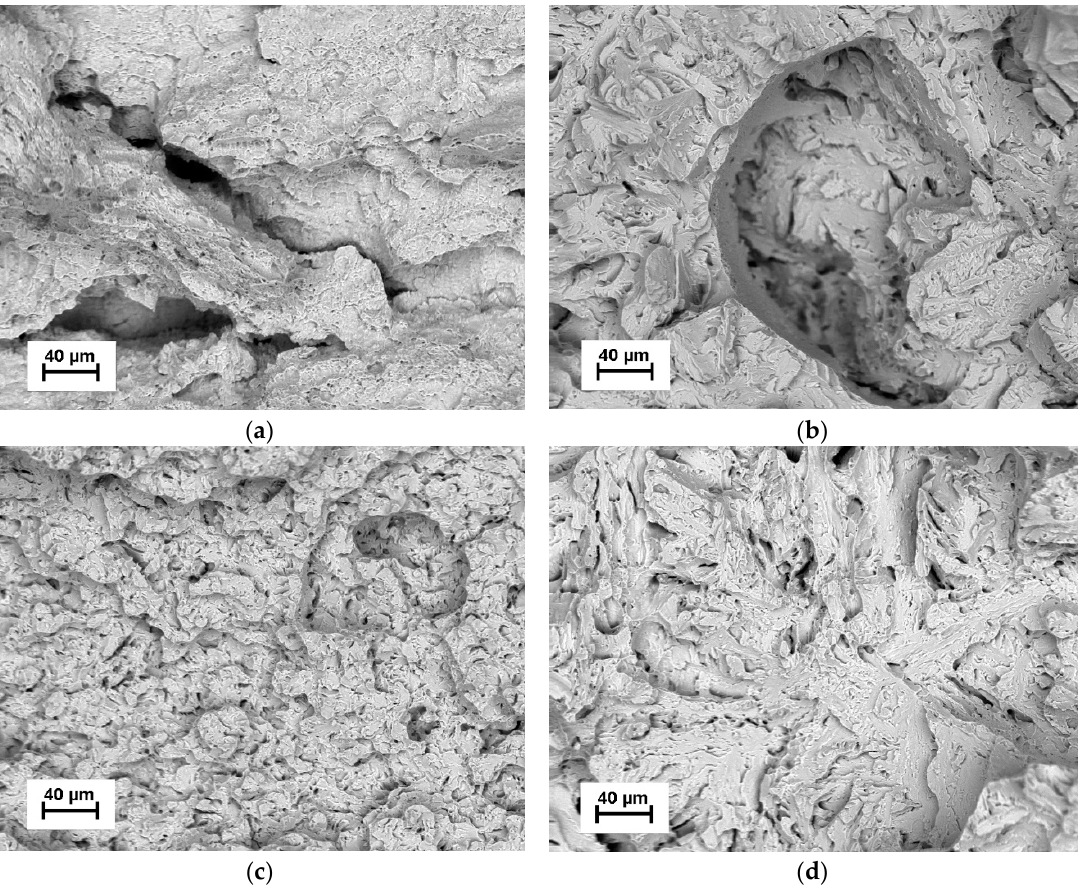
Figure 11. Fracture surface of the impact test specimens: ( a) base material; ( b ) CGHAZ at t 8/5 = 15 s; ( c ) ICHAZ at t 8/5 = 15 s; ( d ) ICCGHAZ at t 8/5 = 15 s (M = 250×).